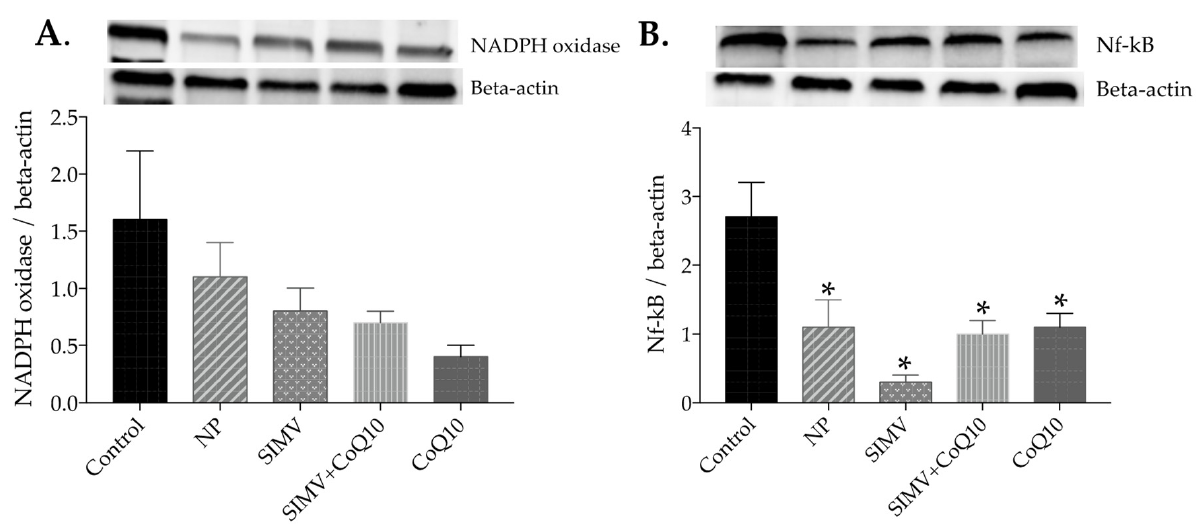
Figure 5. Expression levels and representative Western blot images of nicotinamide adenine dinucleotide phosphate (NADPH) oxidase ( A ) and nuclear factor kappaB (NF-kappaB) ( B ) in the aorta of the control group and groups treated with empty nanoparticles (NP), simvastatin-loaded nanoparticles (SIMV), combination of simvastatin-loaded and coenzyme-Q10-loaded nanoparticles (SIMV+CoQ10), and coenzyme-Q10-loaded nanoparticles (CoQ10). * p < 0.01 compared to the control obese Zucker rats. Data are means ± SEM from 6 animals in each group.